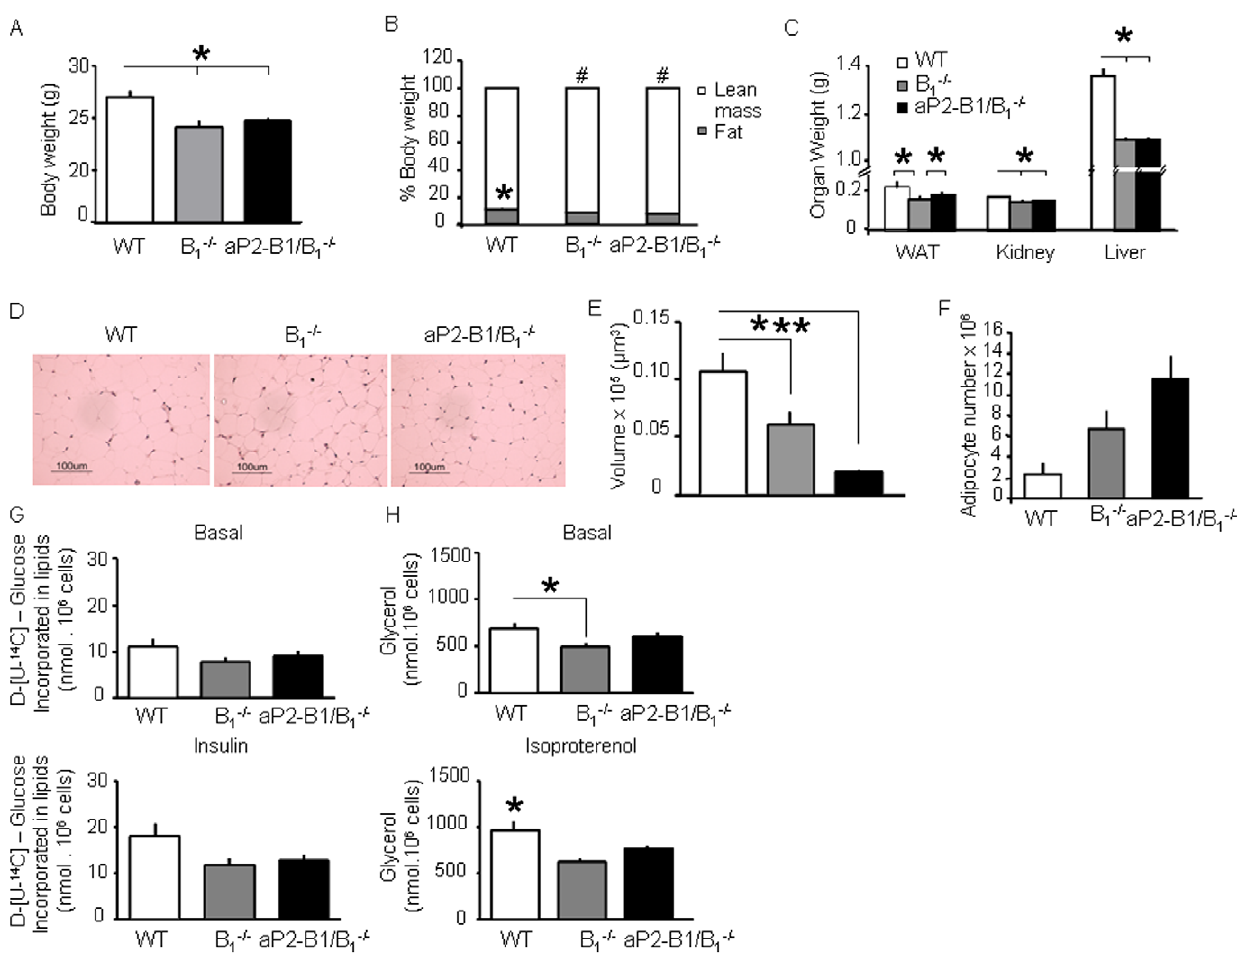
Figure 4. aP2-B 1 / 2 B 1 2 / 2 mice are lean. A: Body weight. B: Body composition. *, P , 0.05 vs. B 1 2 / 2 and aP2-B 1 /B 1 2 / 2 , fat mass comparison; # , P , 0.05 vs. WT, lean mass comparison. C: Organ weight. D: Histology of adipose tissue (H&E staining). Representative pictures of at least five animals per group. E: Adipocyte volume. F: Adipocyte number. G: Basal and maximum (insulin-stimulated) lipogenesis in isolated adipocytes. H: Basal and isoproterenol-induced lipolysis as determined by glycerol production by isolated adipocytes. Values are means 6 SEM of six animals per group. *, P , 0.05; **, P , 0.001.